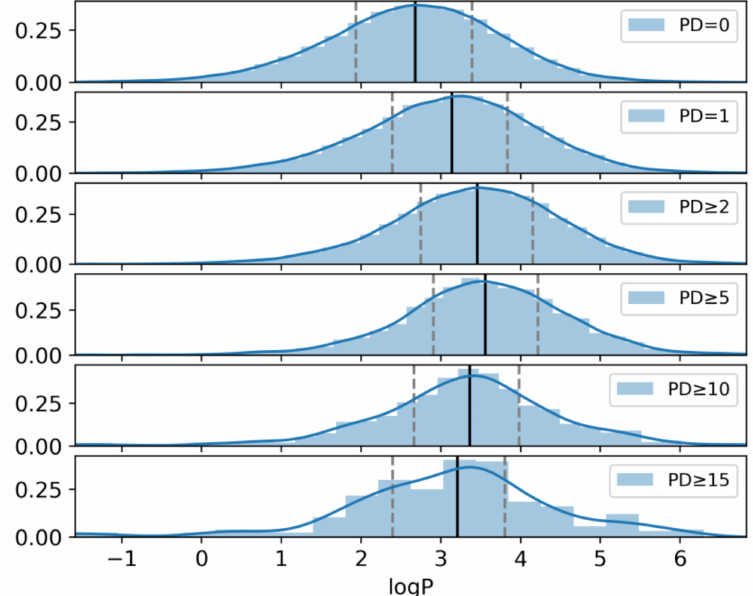
Figure 6. Shown is the kernel density estimation of logP values for di ff erent subsets of compounds with increasing promiscuity. In addition, for each subset, a histogram of the value distribution is shown (light blue) and the median logP value (black vertical line) and the first and the third quartile (gray vertical dashed lines) are